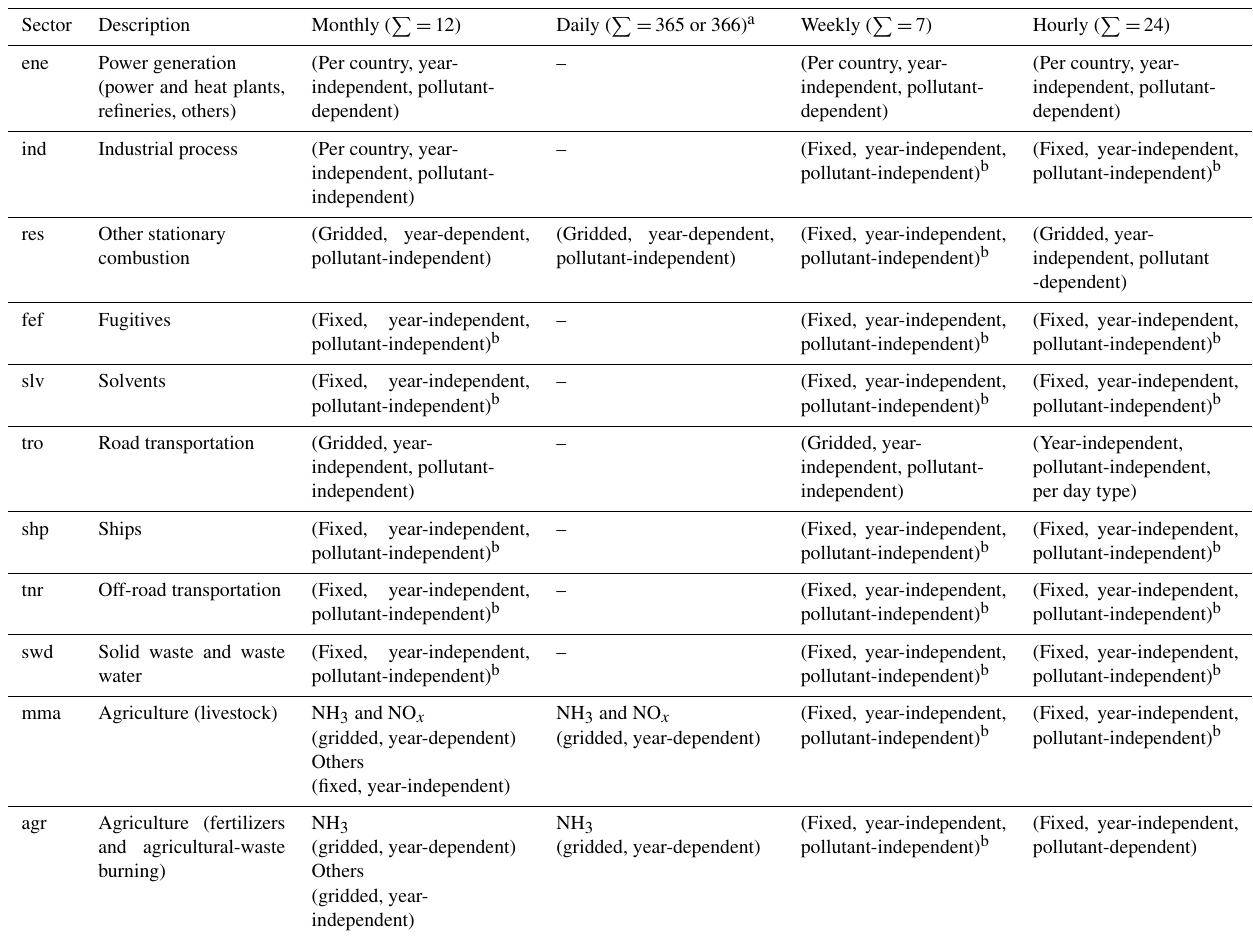
Table 2. Main characteristics of the CAMS global temporal profiles (CAMS-GLOB-TEMPO) reported by sector and temporal resolution (monthly, daily, weekly and hourly). The text between brackets gives information on the spatial resolution and pollutant and year dependency of each profile. Gridded indicates that the profile varies per grid cell within a country; per country indicates that the profile varies only per country; fixed indicates that the profile is spatially invariant; year-independent indicates that the profiles does not vary per year; year- dependent indicates that the profile varies per year; pollutant-independent indicates that the same profile is proposed for all pollutants (NO x , SO x , NMVOC, NH 3 , CO, PM 10 , PM 2 . 5 , CO 2 and CH 4 ); pollutant-dependent indicates that the profile varies per pollutant; per day type indicates that the profile varies as a function of the day (weekday, Saturday and Sunday). The symbol “–” denotes that no profile is